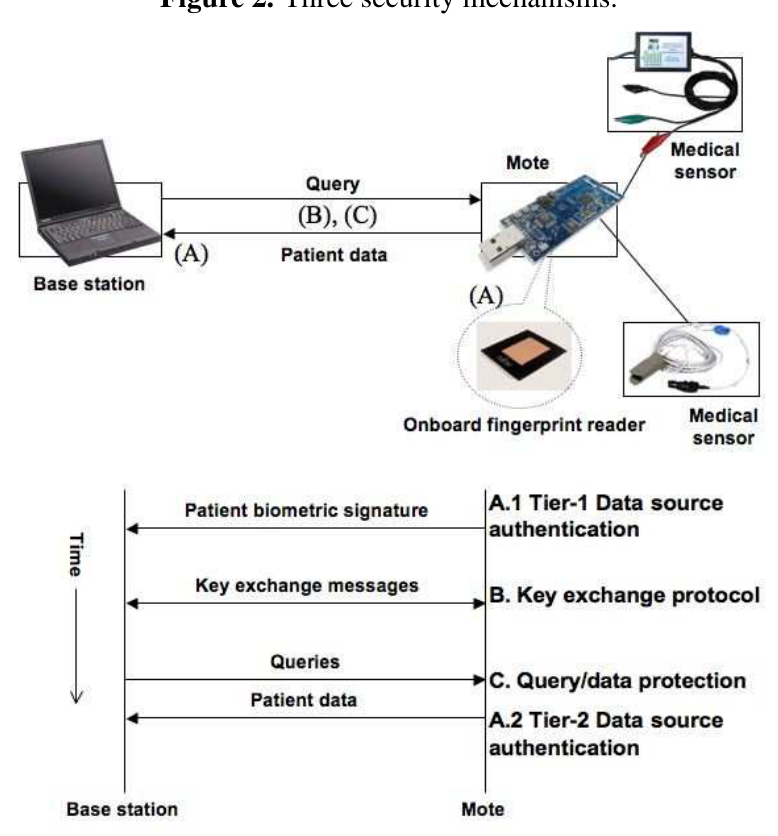
Figure 2. Three security